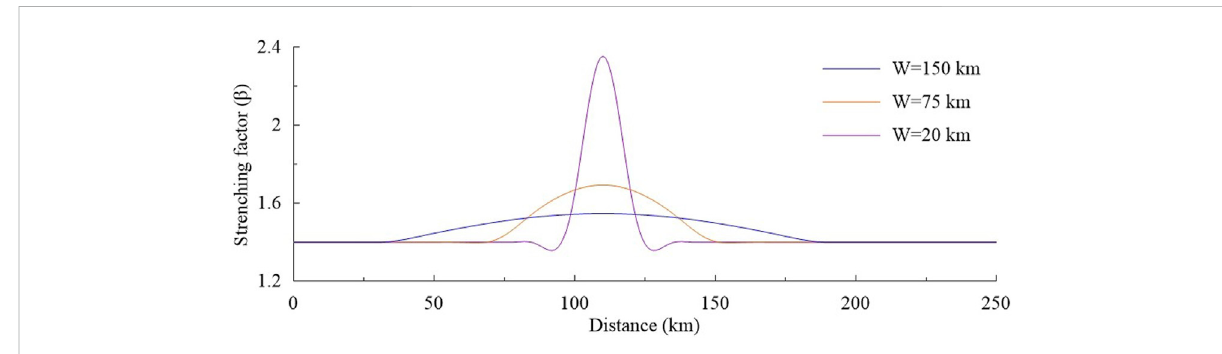
FIGURE 8 β -Pro fi les generated from different values of W and the same single fault based on Eqs 1, 2, all with 40%